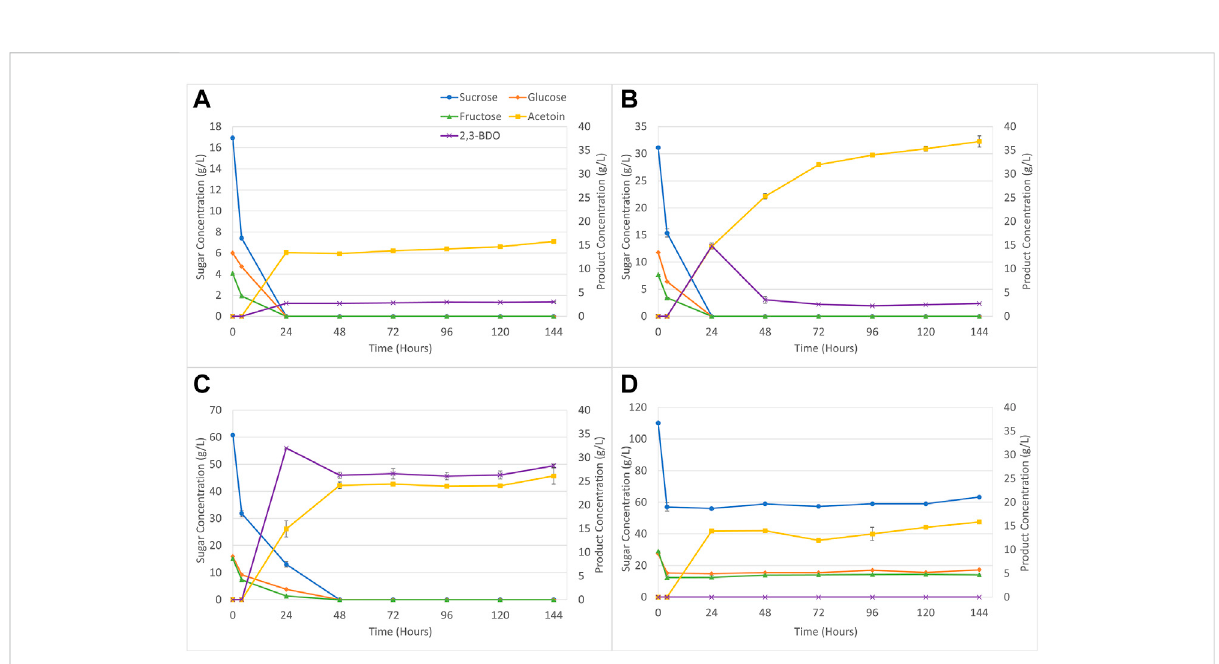
FIGURE 2 P. polymyxa sugar consumption and product generation during aerobic fermentation for (A) 12.5 g/L molasses loading, (B) 25 g/L molasses loading, (C) 50 g/L molasses loading, and (D) 100 g/L molasses